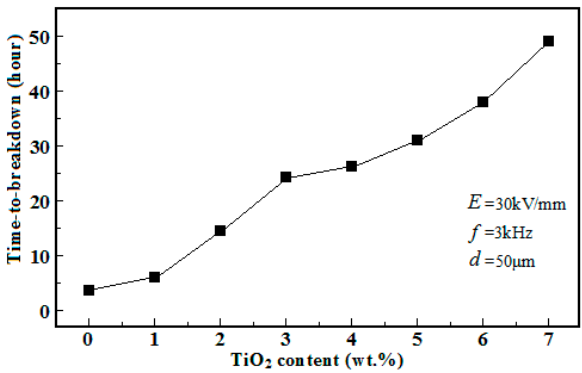
Figure 6. Time-to-breakdown data for PI/TiO 2 composite films with different TiO 2 contents.